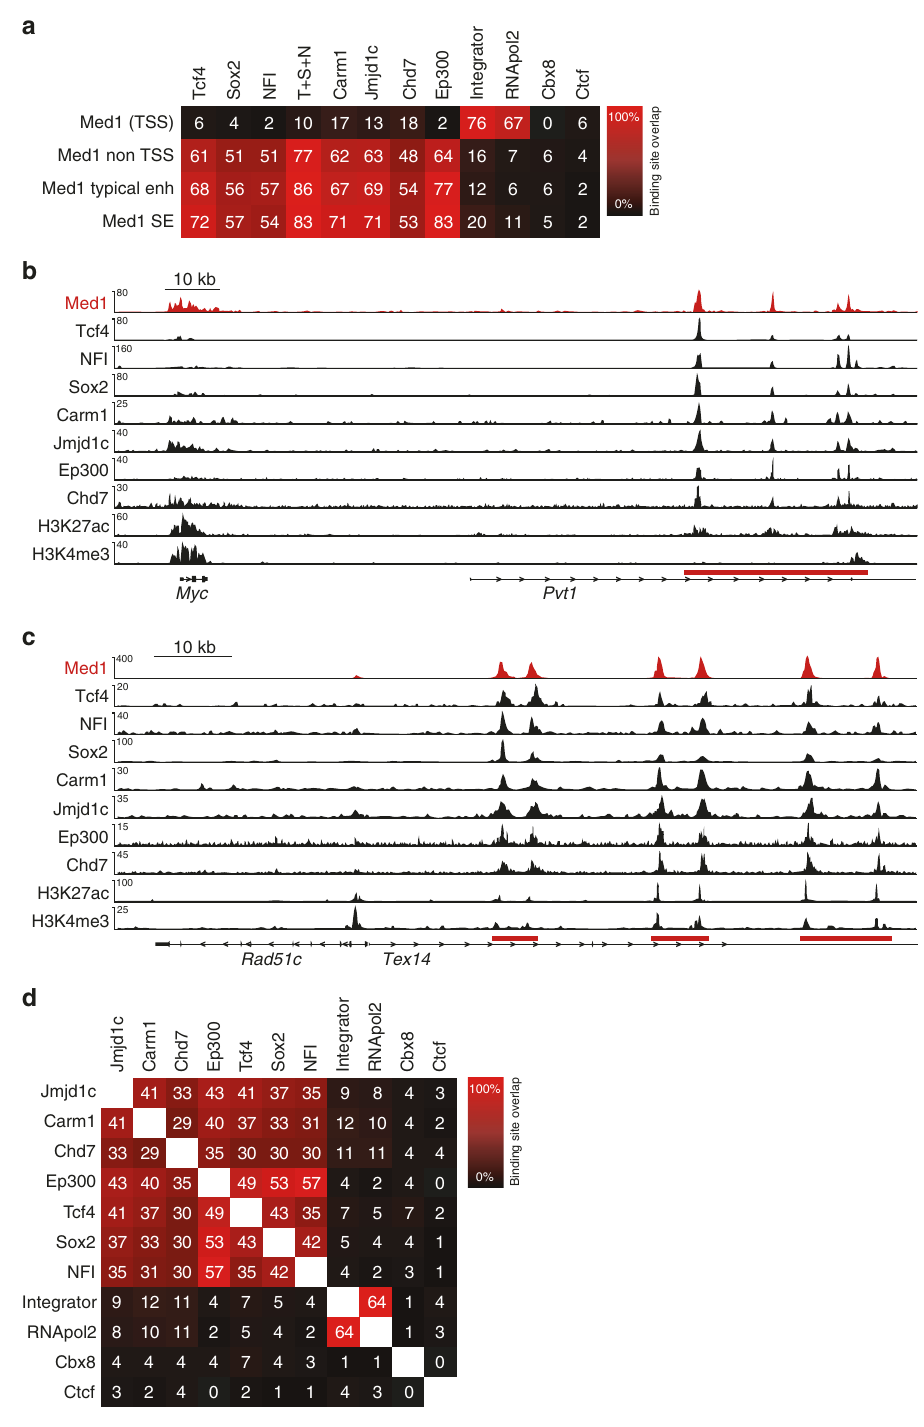
Fig. 4 Binding site overlap of Mediator complex and its interactors. a Percentage overlap of genome-wide binding sites of Mediator (Med1) with Mediator- interactors Tcf4, Sox2, NFI (N fi a + N fi b), Carm1, Jmjd1c, Chd7, Ep300, Integrator complex (Ints11 subunit), and RNApol2 in NSCs. Cbx8 and Ctcf were not identi fi ed as Mediator interactors and serve as negative controls. Percentages overlap of binding sites, as determined by ChIP-seq, are indicated. T + S + N, sum of the binding sites of Tcf4, Sox2, and NFI. TSS, within 1 kb of a transcription start site. b Overlap of binding sites of Mediator (Med1) with binding sites of Mediator interactors at the Myc locus in NSCs. ChIP-seq tracks for the indicated proteins and histone modi fi cations at the Myc gene are shown. The Myc SE in the adjacent (inactive) Pvt gene is indicated with a red bar. Range of reads per million per base pair is indicated on the y -axis. Scale bar is indicated. c Overlap of binding sites of Mediator (Med1) with binding sites of Mediator interactors at the Rad51c locus in NSCs. ChIP-seq tracks for the indicated proteins and histone modi fi cations at the Rad51c gene are shown. The Rad51c SEs in the adjacent (inactive) Tex10 gene are indicated with red bars. Range of reads per million per base pair is indicated on the y -axis. Scale bar is indicated. d Overlap of genome-wide binding sites of Mediator interactors and Cbx8 and Ctcf in NSCs. Percentages overlap of binding sites, as determined by ChIP-seq, are